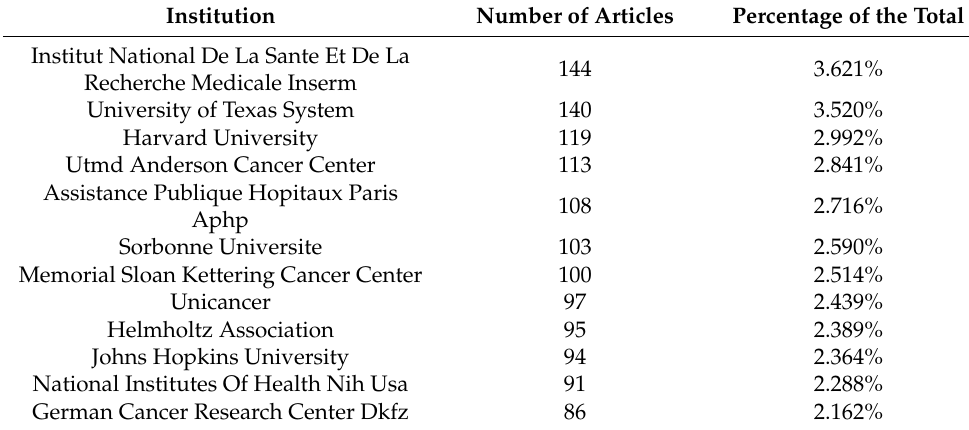
Table 1. Top 10 institutions in the field immunotherapy research related to colorectal